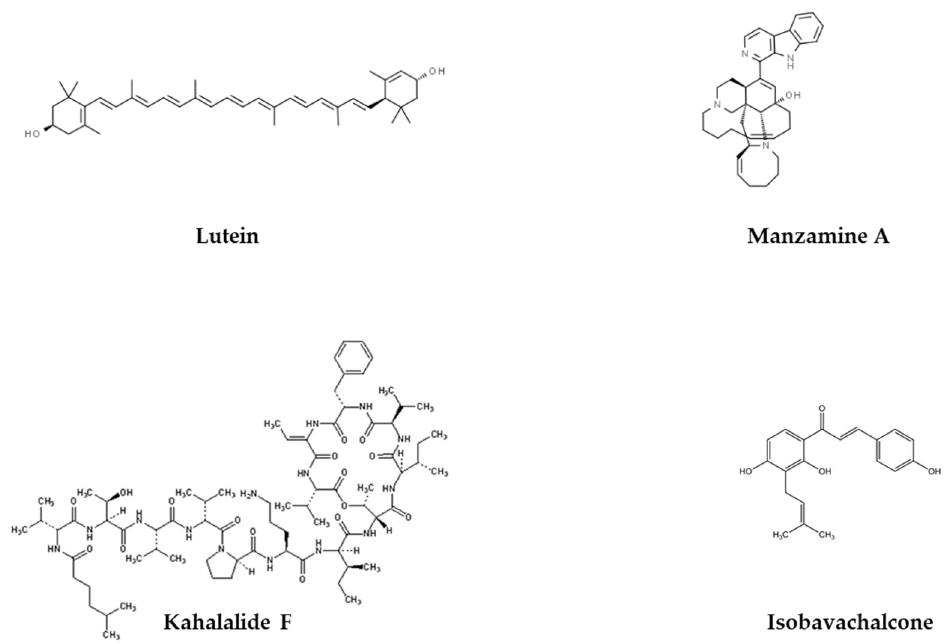
Table legend. Abbreviations for C. elegans developmental stages and phenotype : GA: gravid adult ; L4: larval stage 4 ; L3: larval stage 3 ; L2: larval stage 2 ; Starved: Describes lack of food left on the plates because of progeny